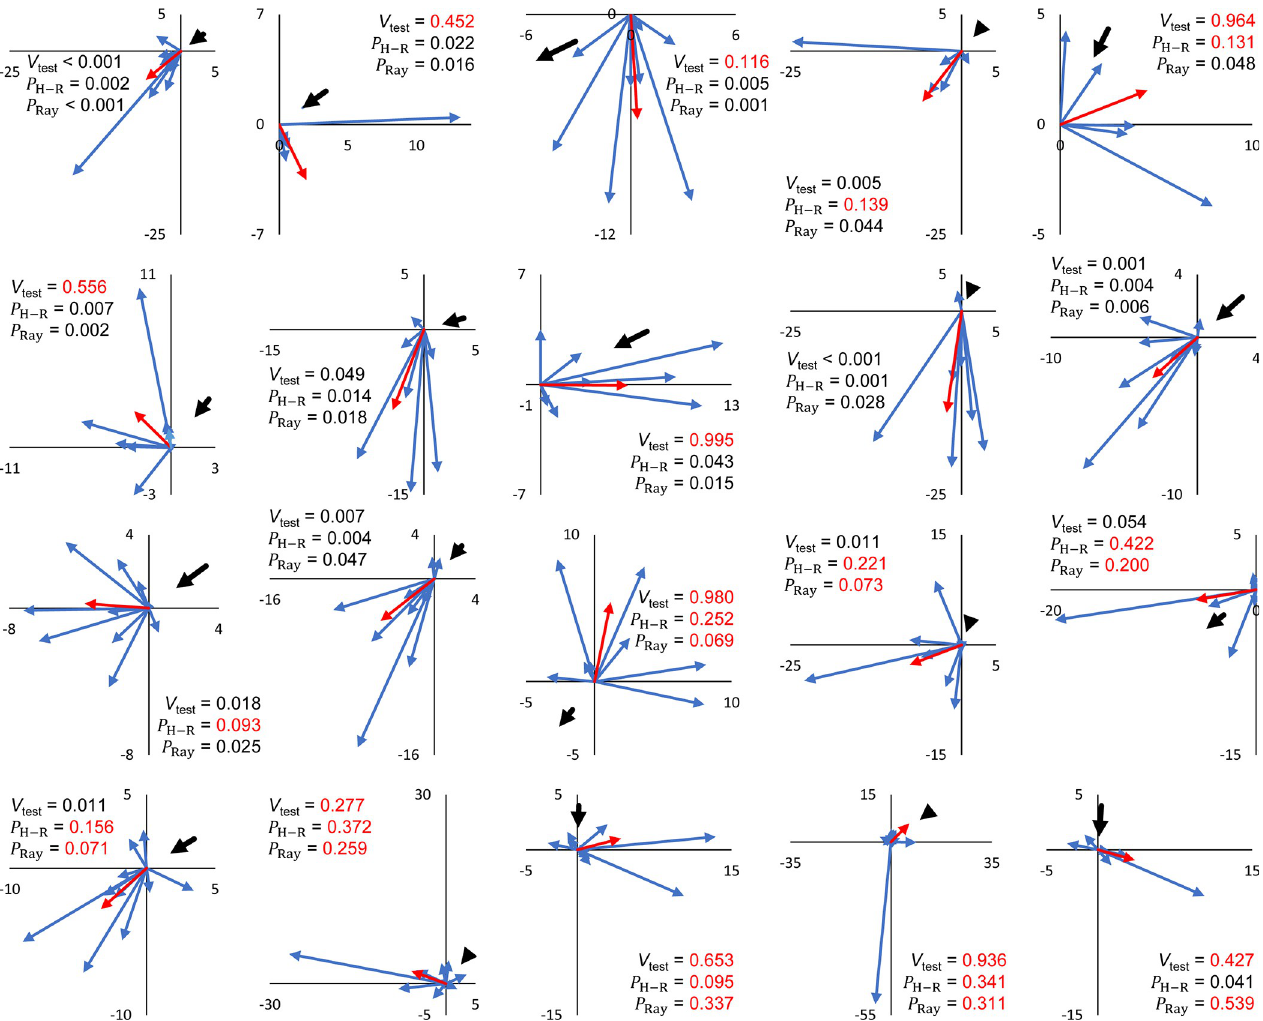
Fig 7. Flight directions and lengths of HR tagged Zeugodacus cucurbitae for experiment 4 (papaya field). Each replicate consisted of a series of 5–10 flights with a single tagged fly. Blue arrows represent individual flights, while red arrows show the mean flight direction and length.